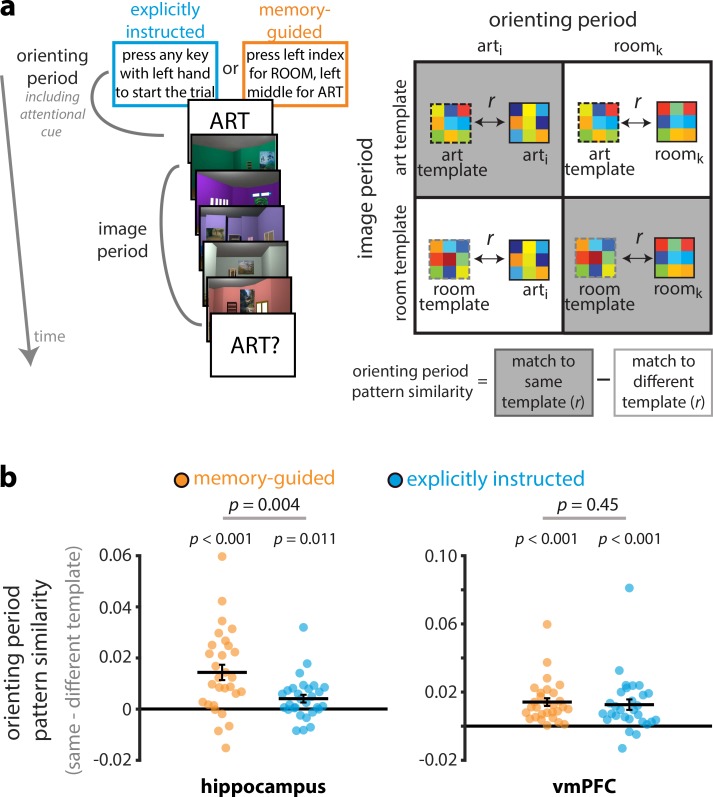
Representations of upcoming attentional states.(A) Art and room attentional state ‘templates’ were created by averaging image period activity patterns across trials, separately for art and room attentional states. Next, the orienting period activity pattern for each trial was correlated with these templates to obtain match to same template (e.g., room orienting period to room template) and match to different template (e.g., room orienting period to art template) pattern similarity values. Lastly, the match-to-different-template correlation was subtracted from the match-to-same-template correlation to obtain a measure of preparatory attentional state representations. (B) Pattern similarity values are shown as difference scores between the match-to-same-template correlation and the match-to-different-template correlation: More positive values indicate more evidence for the upcoming attentional state, and more negative values indicate more evidence for the other attentional state. Both the hippocampus and vmPFC showed preparatory coding, with orienting period activity patterns resembling the upcoming attentional state more than the other attentional state. In the hippocampus, this preparatory coding was stronger for memory-guided vs explicitly instructed attention. Circles and solid lines show individual and average pattern similarities, respectively. The results are shown as Pearson correlations, but statistical tests were performed after applying the Fisher transformation. The error bars indicate standard error of the mean for the within-participant difference in attentional state match (i.e., match to same template – match to different template) for each task.